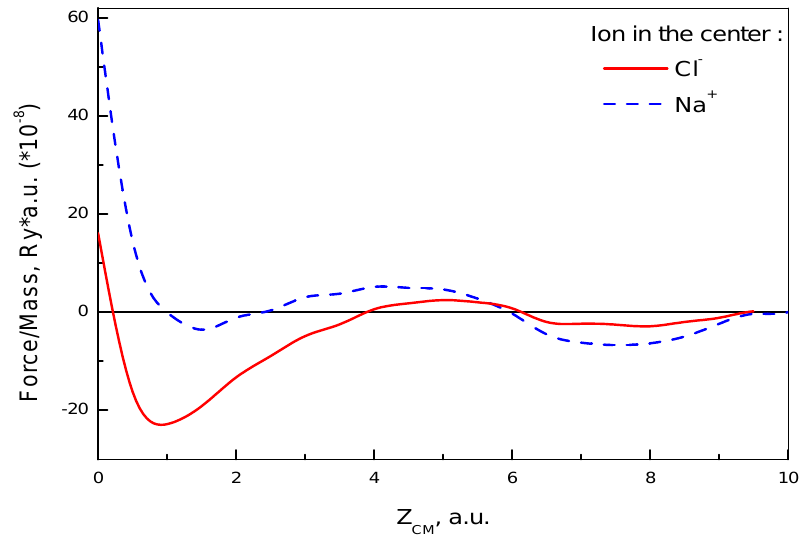
Figure 2: Effective force as a function of the distance between cluster and surface for two cases with a Na + and a Cl − ion in the